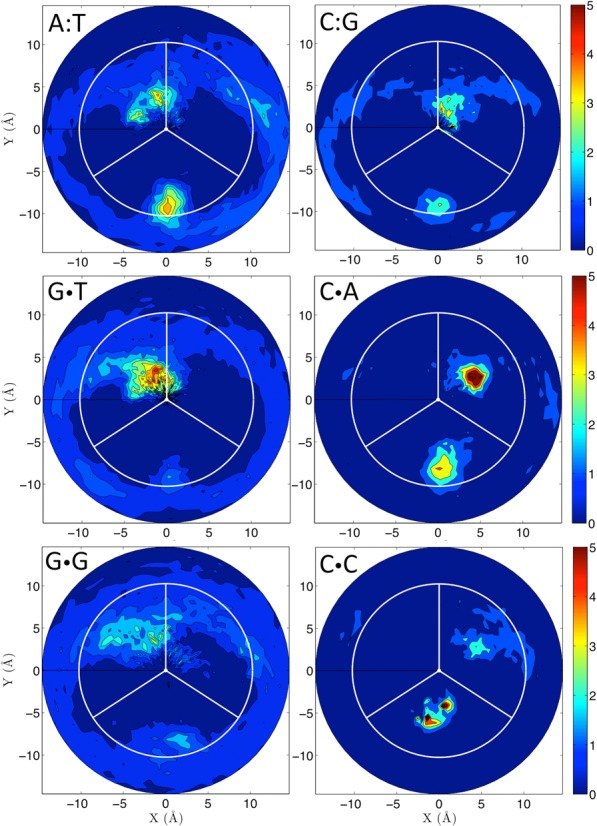
Distortion of the ionic atmosphere. Two-dimensional cation distributions averaged over the last 100 ns of the trajectories. The plot show the radial-angular plane at the central MM base pair, the minor groove limits as white lines and the center of the major groove as a vertical radial vector. The results are plotted as molarities as shown by the color bars, with a blue to red concentration scale that goes from 0 to 5 molar. The two canonical base pairs (A:T, C:G) and four selected MMs in the flexible environment are shown.